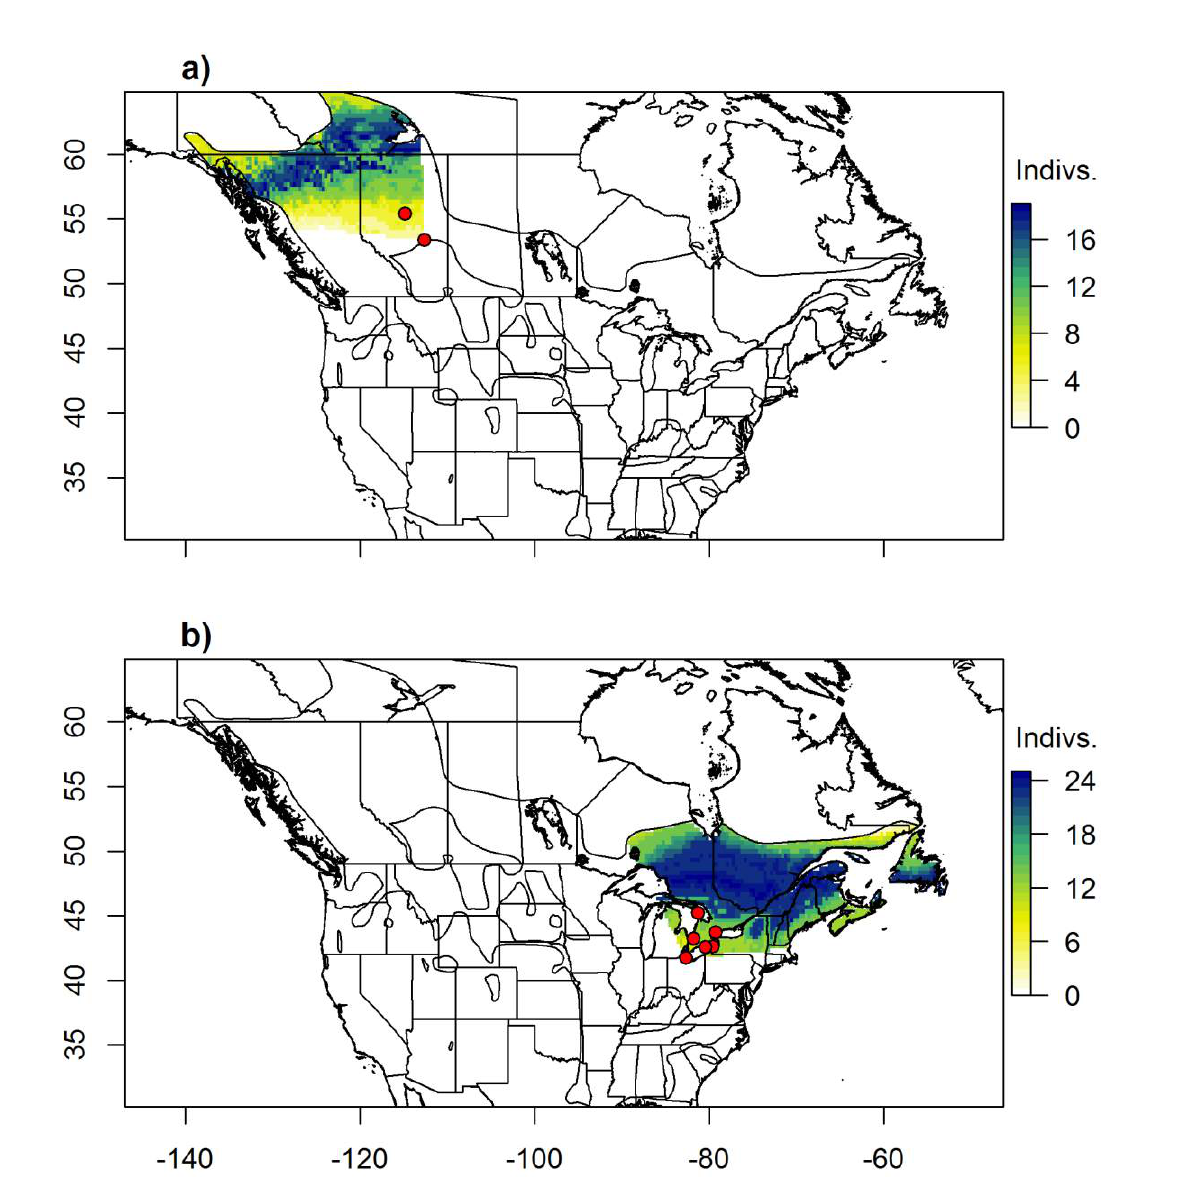
Figure A2.13: Probable origins of American Redstarts ( Setophaga ruticilla ) captured during spring migration at CMMN stations in a) Northern Alberta (BBO (n=1), LSLBO (n=25)); and b) Southwest Ontario (AuBO (n=5), BPBO (n=5), HBO (n=5), LPBO (n=6), PIBO (n=3), TTPBRS